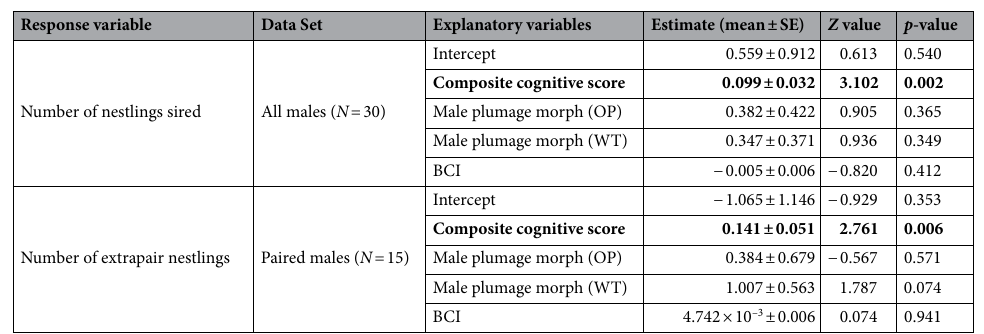
Table 1. Effects of male composite cognitive score, male plumage morph, and male body condition index (BCI) on number of nestlings sired and number of extrapair nestlings. Significant results are indicated in